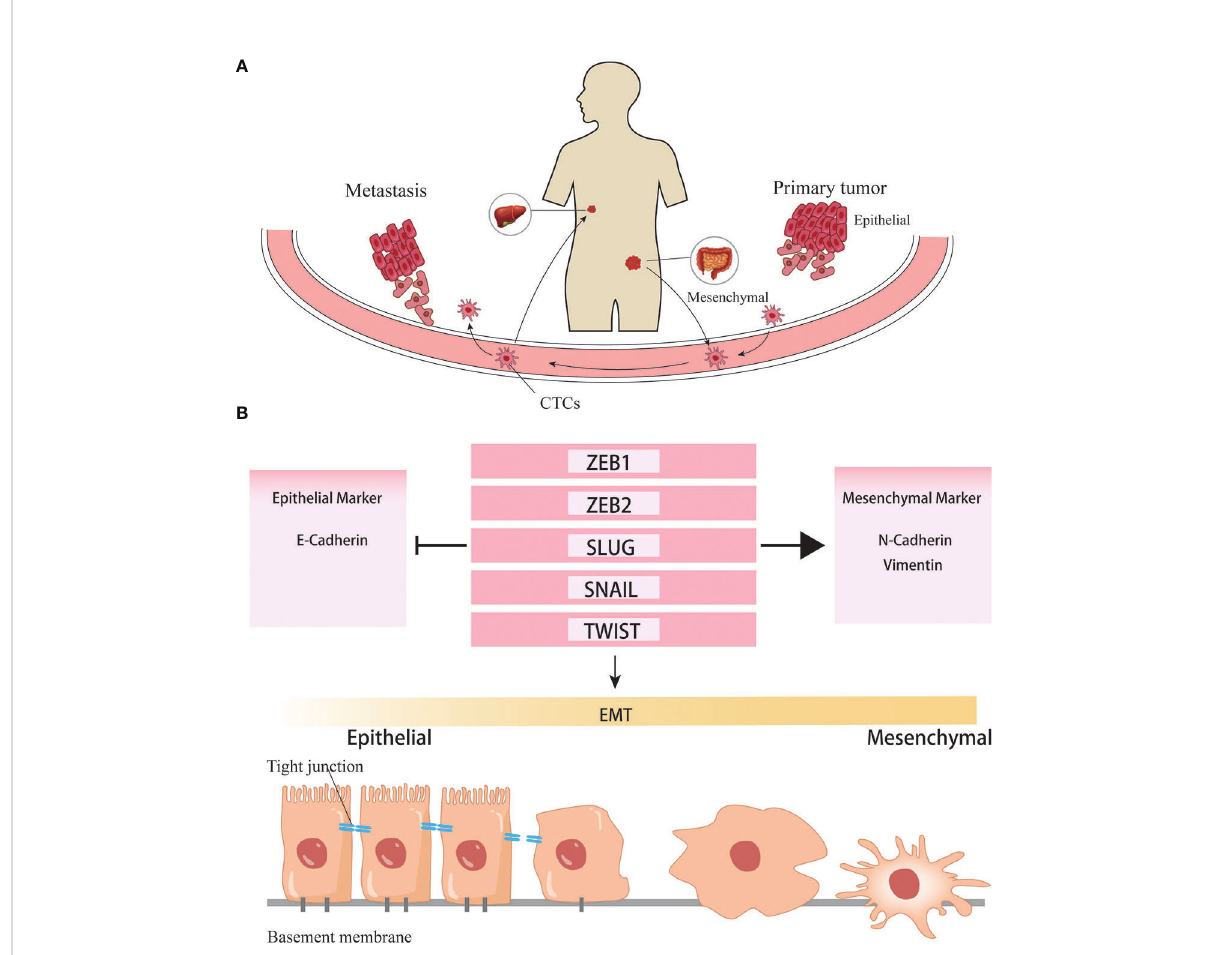
FIGURE 3 EMT helps the formation of distant metastasis. (A) Cancer cells undergone EMT programs acquire the ability to invade into vascular and colonize to distant organ. (B) Transcription factors involved in the EMT